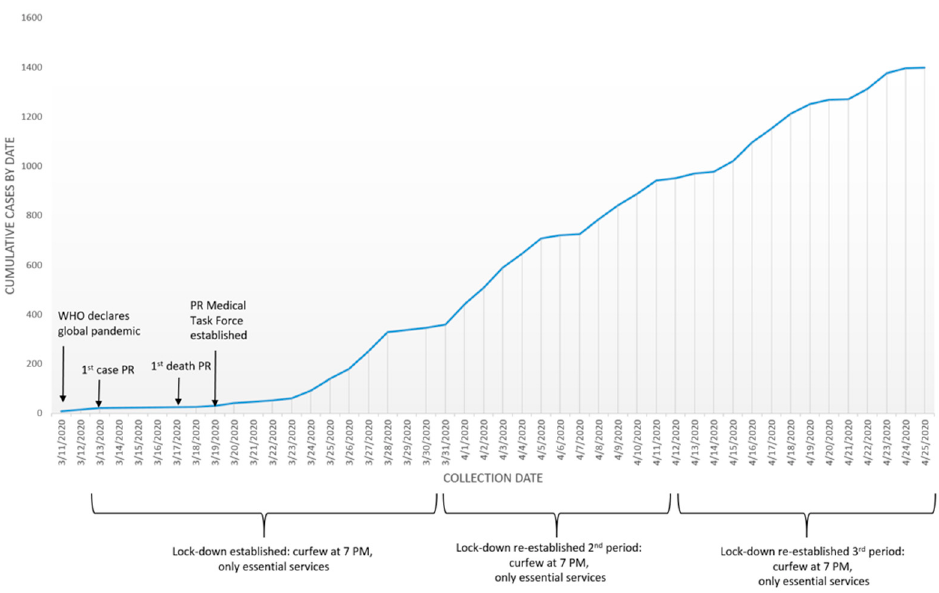
Figure 1. Public health response to the coronavirus disease 2019 (COVID-19) pandemic in Puerto Rico.